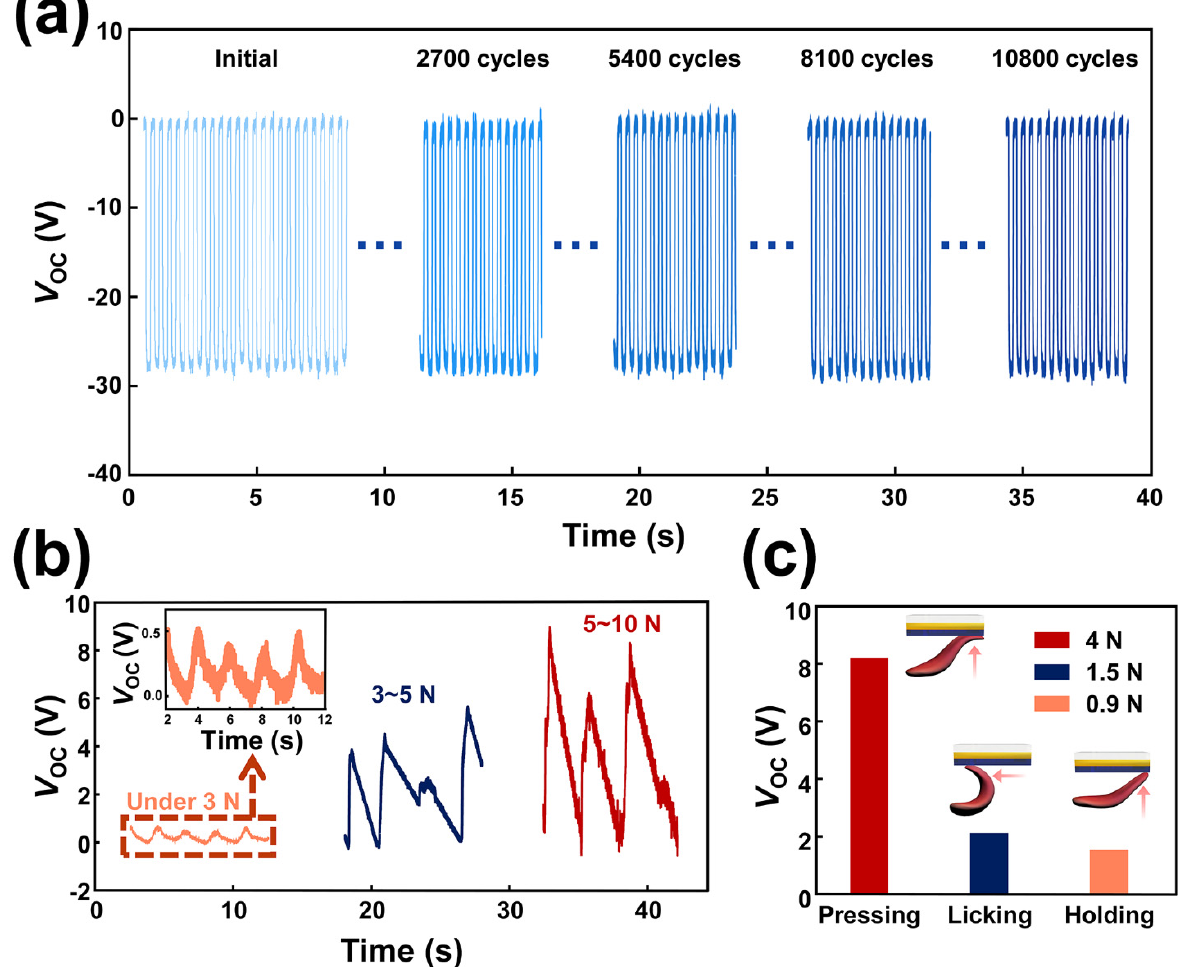
Figure 4. The durability and ability to detect the motion of the tongue. ( a ) The durability of the fabricated TSR − T60 with the working frequency of 3 Hz. ( b ) Electrical output generated from the TSR − T60 by weak (orange), middle (blue), and strong (red) pressing by the tongue. ( c ) Electrical output generated from the TSR − T60 by pressing, licking, and holding of the tongue with a force of 4 N, 1.5 N, and 0.9 N.